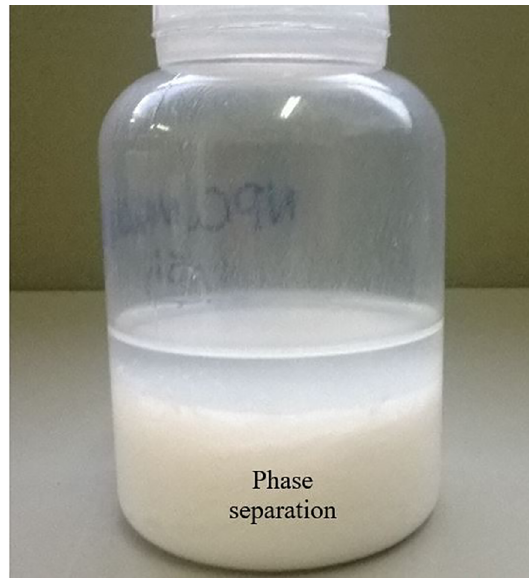
Figure 8. Phase separation in Batch